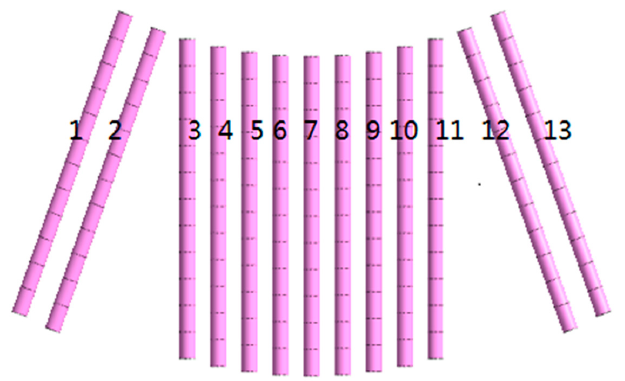
Figure 12. Layout of foundation pile.